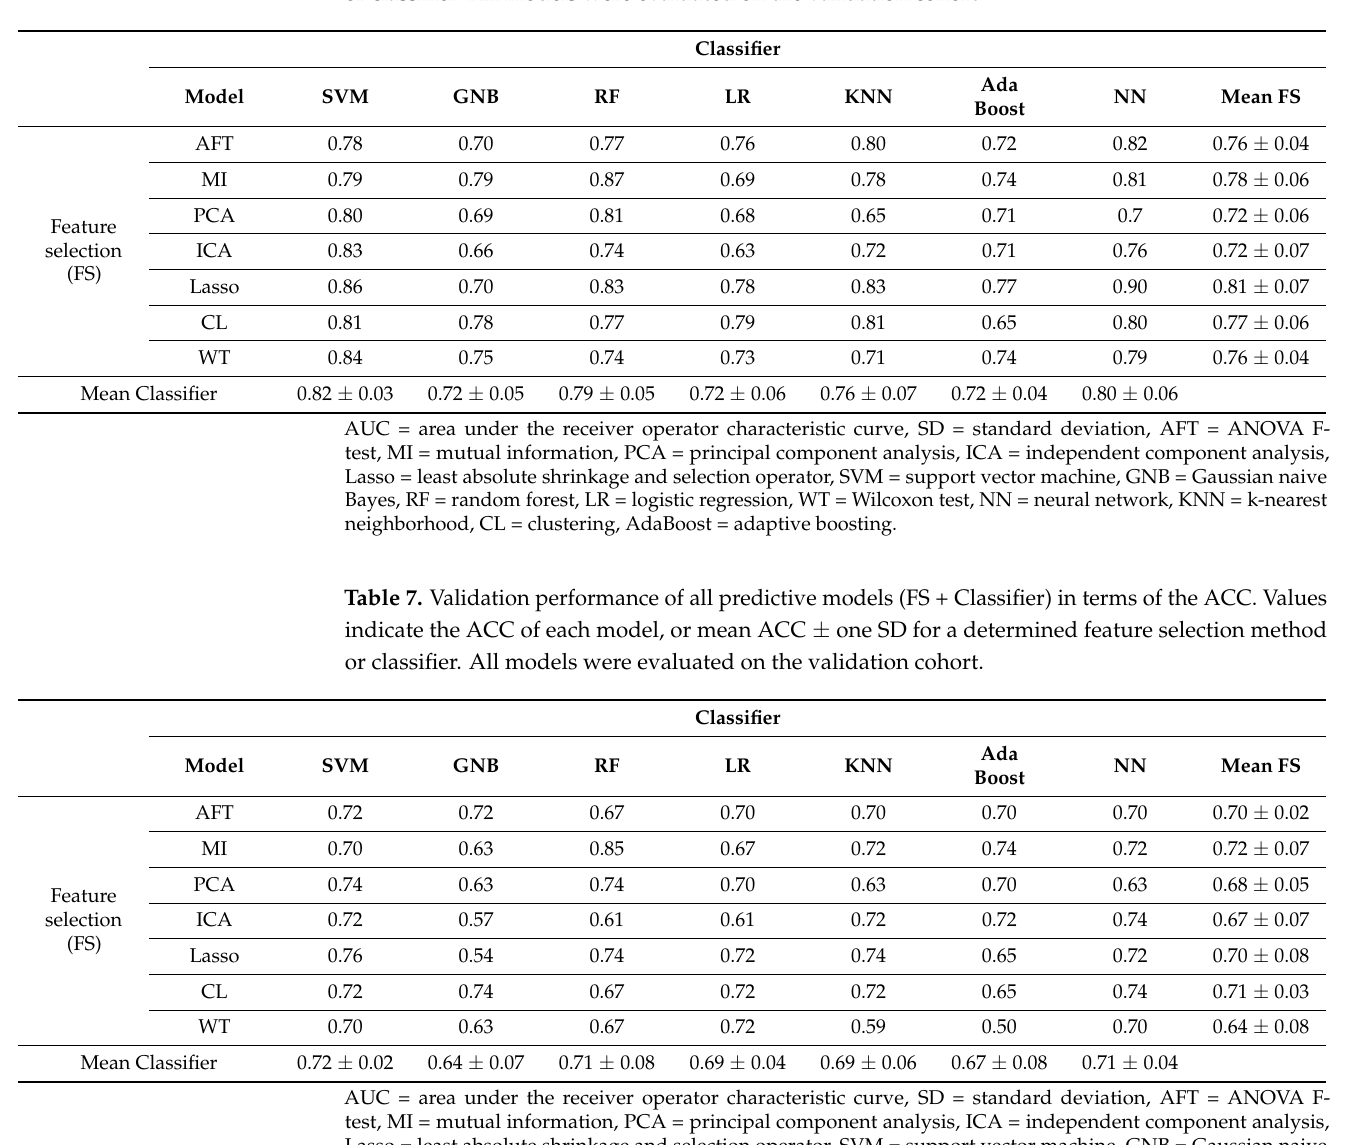
Table 6. Validation performance of all predictive models (FS + Classifier) in terms of the AUC. Values indicate the AUC of each model or mean AUC ± one SD for a determined feature selection method or classifier. All models were evaluated on the validation cohort.